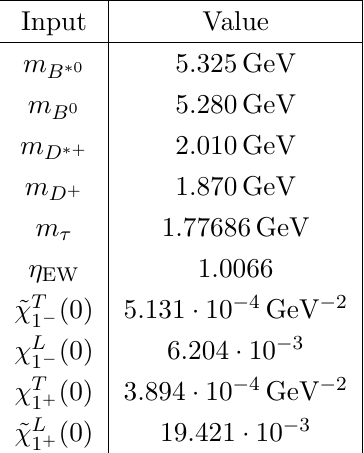
(0) follows refs. [5, 35]. (cid:31) L i